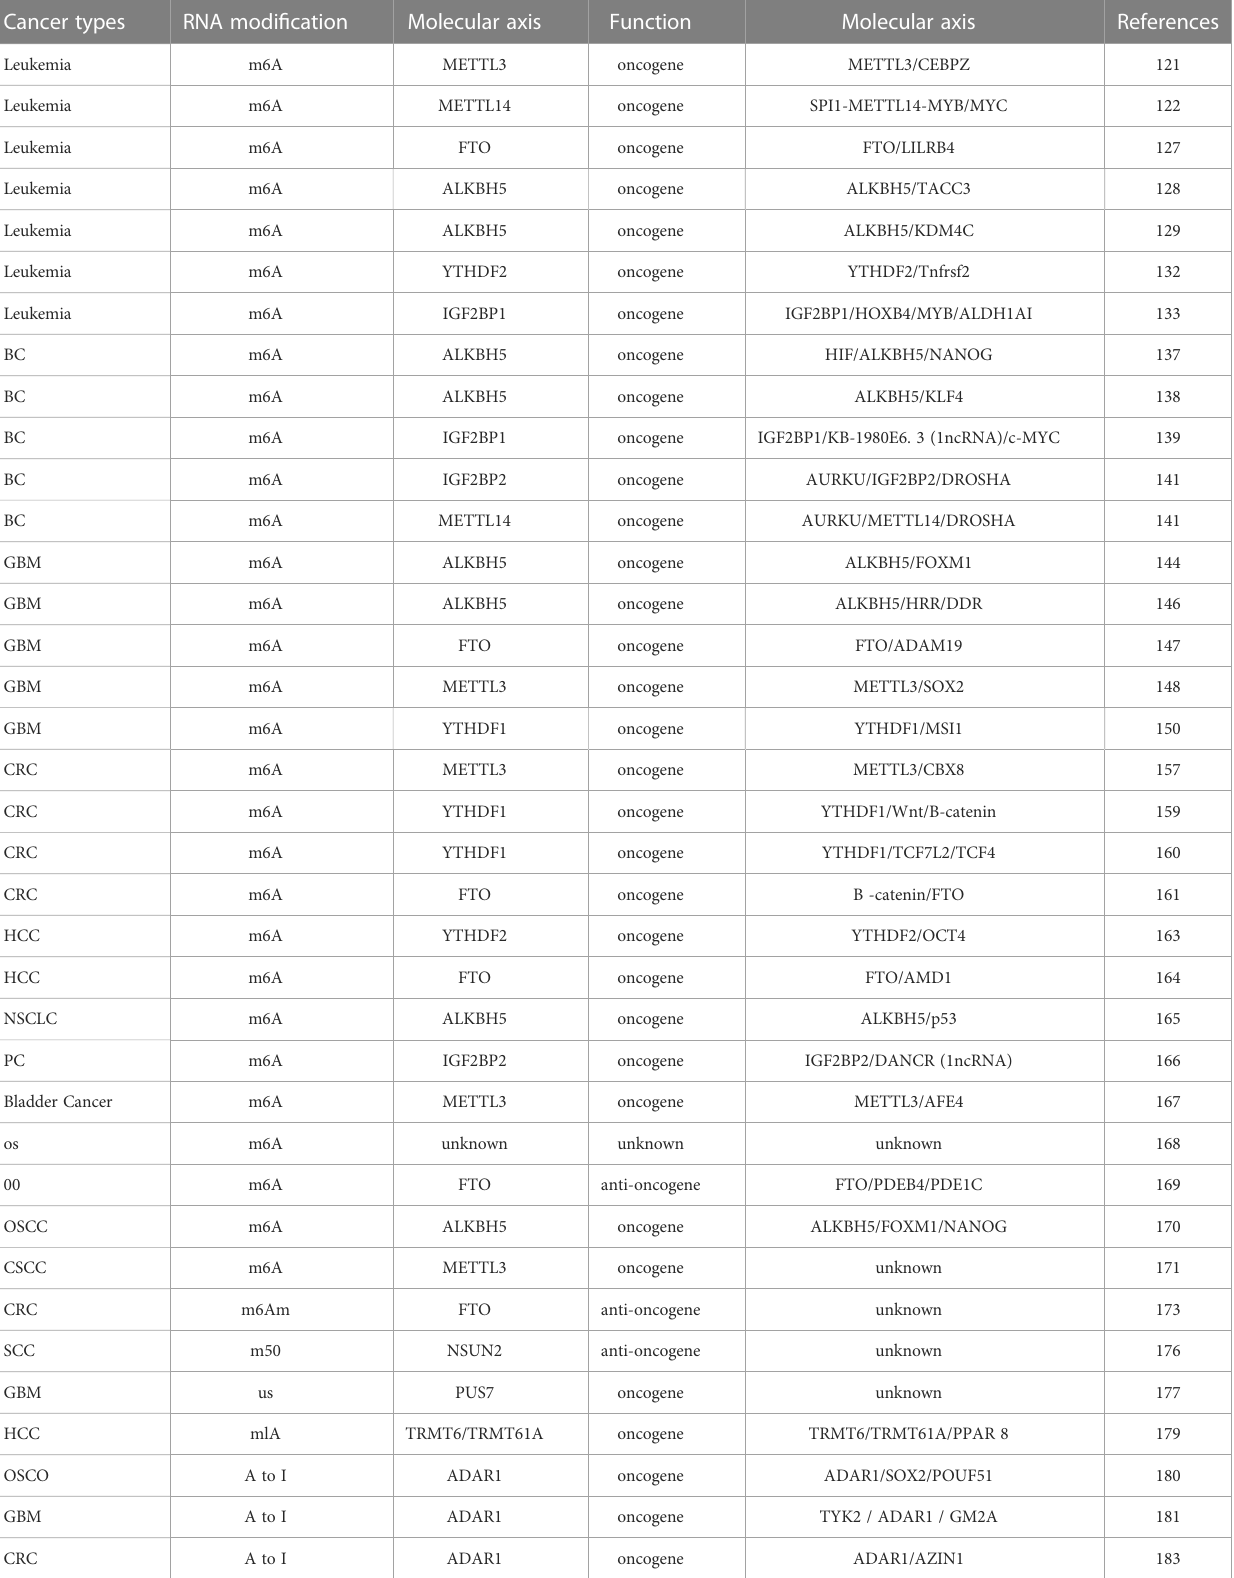
TABLE 1 The main roles of epitranscriptomic factors in